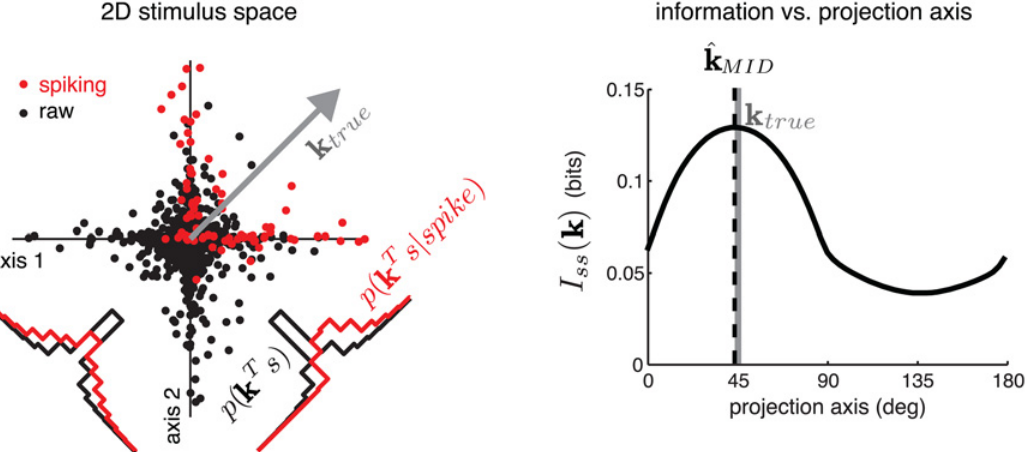
Fig 2. Geometric illustration of maximally-informative-dimensions (MID). Left: A two-dimensional stimulus space, with points indicating the location of raw stimuli (black) and spike-eliciting stimuli (red). For this simulated example, the probability of spiking depended only on the projection onto a filter k true , oriented at 45 (cid:5) . Histograms (inset) show the one-dimensional distributions of raw (black) and spike-triggered stimuli (red) projected onto k true (lower right) and its orthogonal complement (lower left). Right: Estimated single-spike information captured by a 1D subspace, as a function of the axis of projection. The MID ^ k estimate (dotted) corresponds to the axis maximizing single-spike information, which converges asymptotically to k true with dataset size. MID